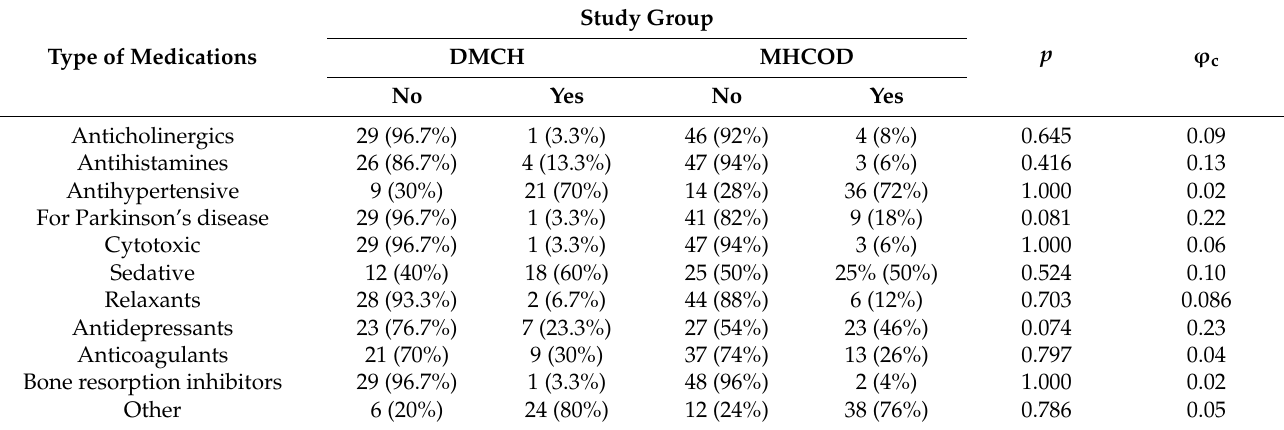
Table 4. Relationship between the type of medication taken and the place of residence.